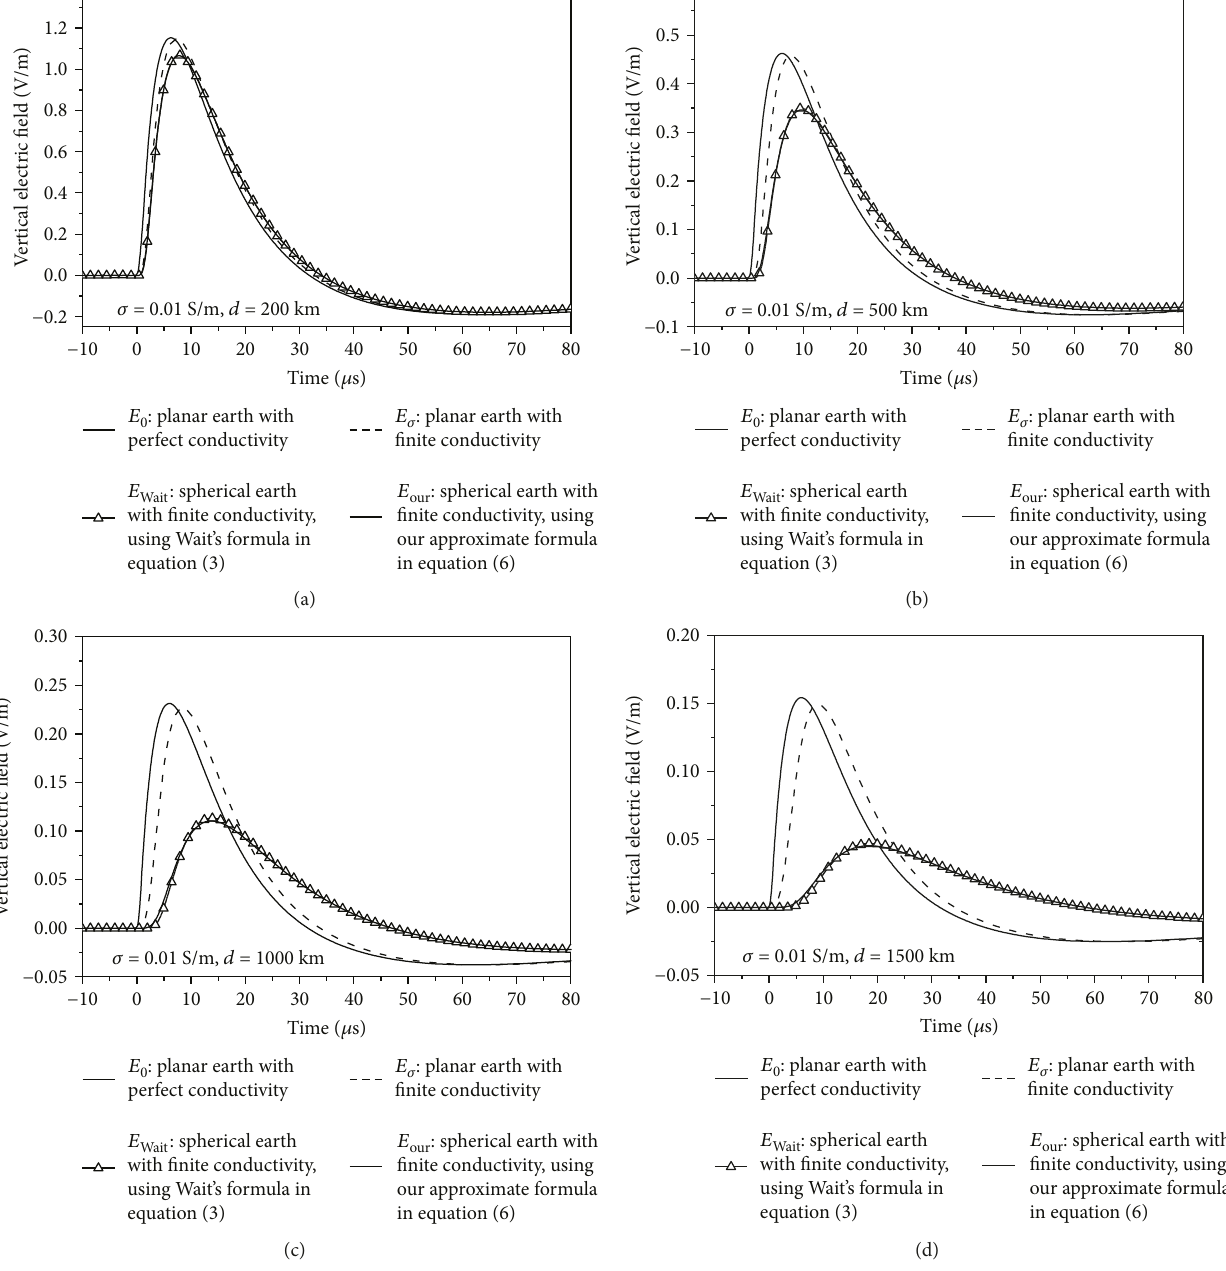
Figure 4: Similar to that of Figure 3 but for fi nite conductivity of 0.01S/m at the di ff erent distances of (a) 200 km, (b) 500 km, (c) 1000km, and (d) 1500